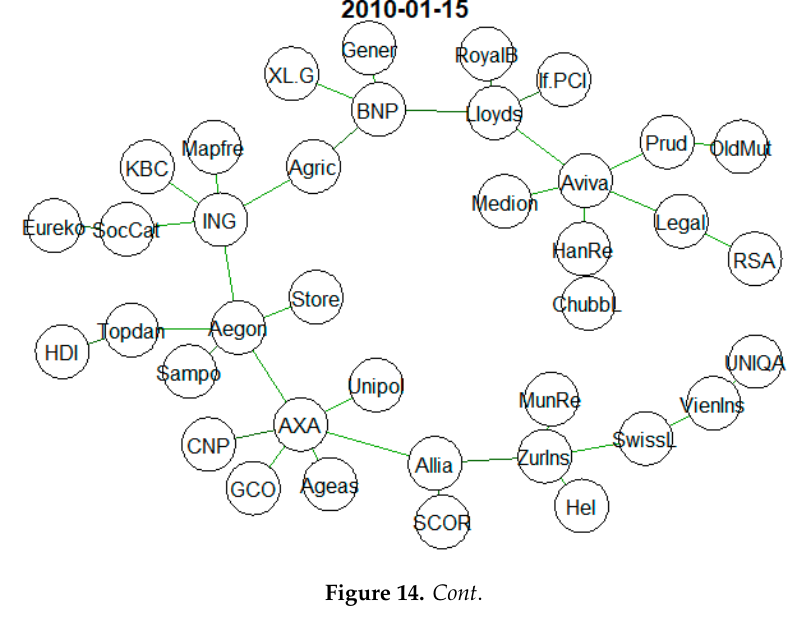
Figure 13. RCE distribution in determined market states based on the mean and the standard deviation for k = 4. Source: Own